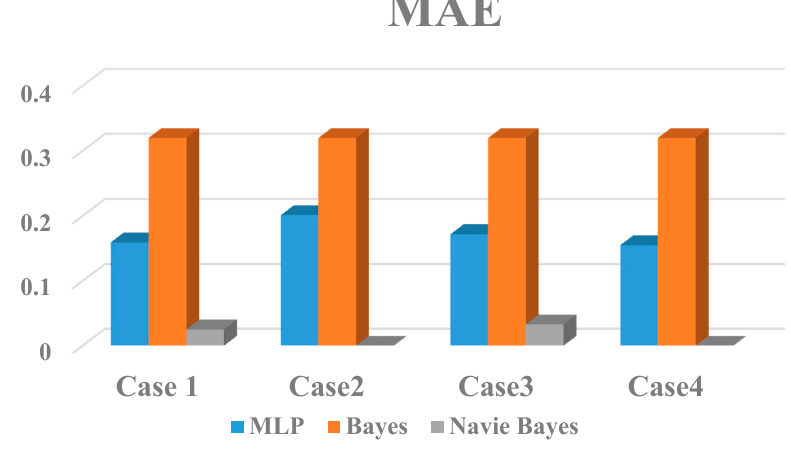
Figure 16. MAE comparison of various classifiers.